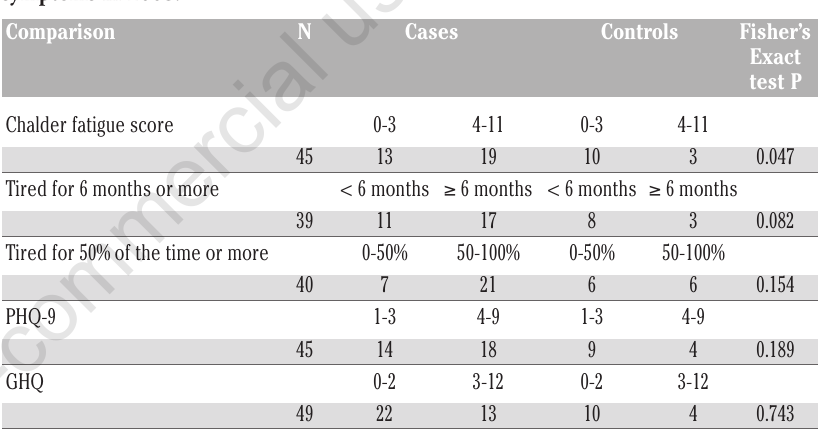
Table 2. Relationship between status as defined in 2002 (cases and controls) and clinical symptoms in 2008.